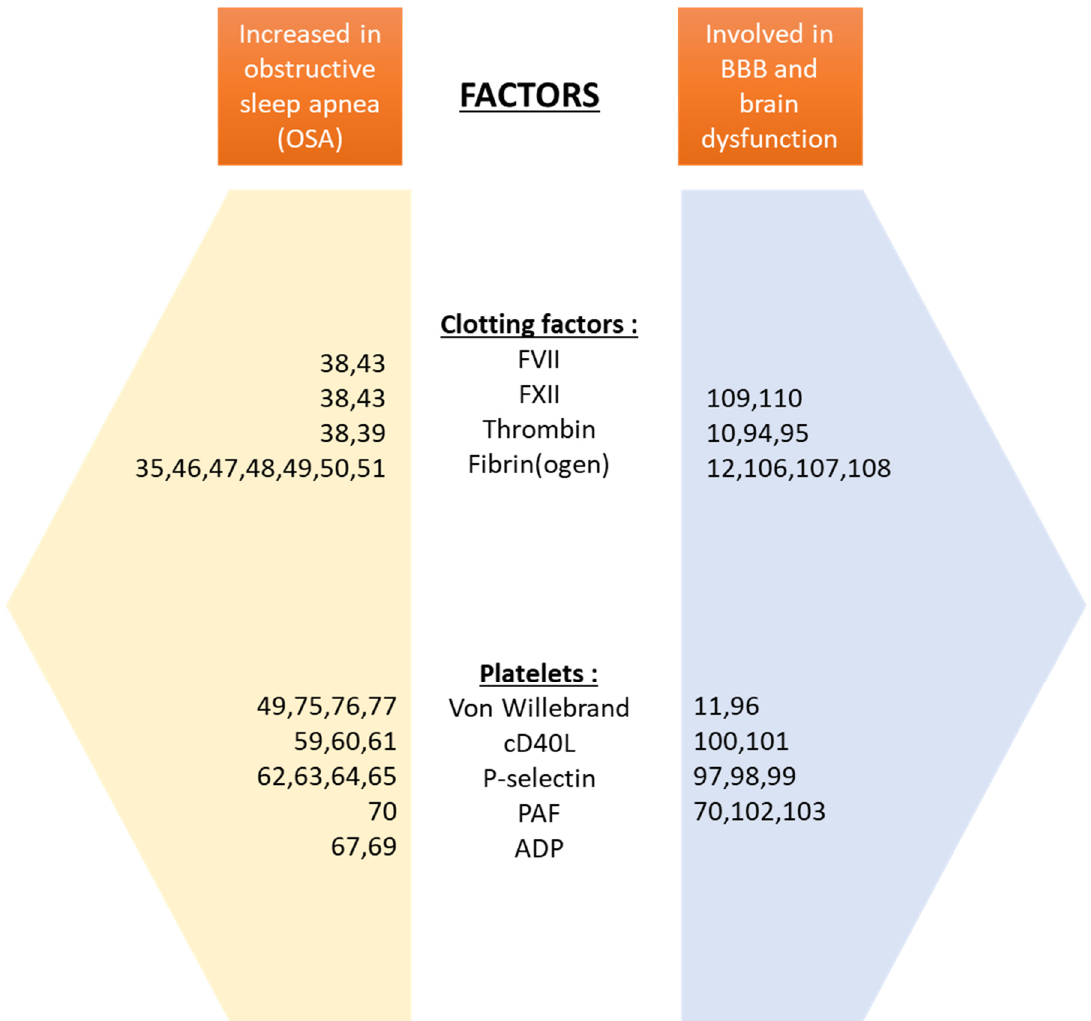
Figure 1 . Summary of the major studies investigating the factors increased during obstructive sleep apnea (OSA) and factors involved in blood–brain barrier (BBB)–brain dysfunction. ADP: adenosine diphosphate, PAF: platelet-activating factor, cD40L: cD40 ligand.